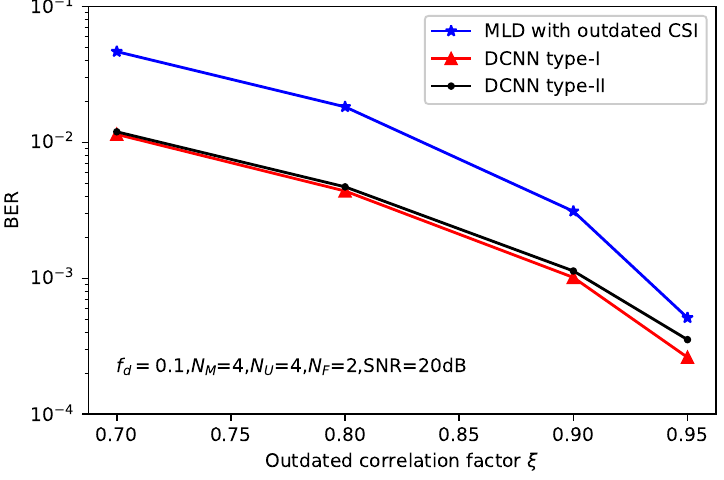
Figure 8. BER performance of deep learning-based MLD with SNR = 20 dB.